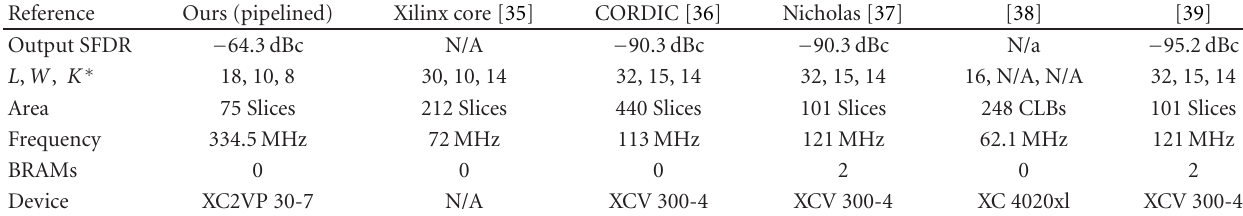
Table 5: Comparison result for DDFS.